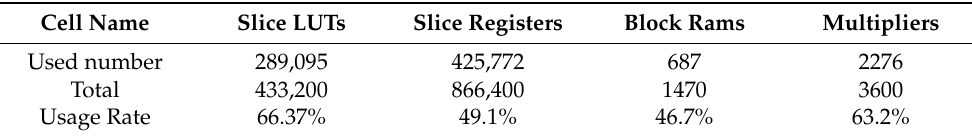
Table 1. Resource consumption of the FPGA modules.